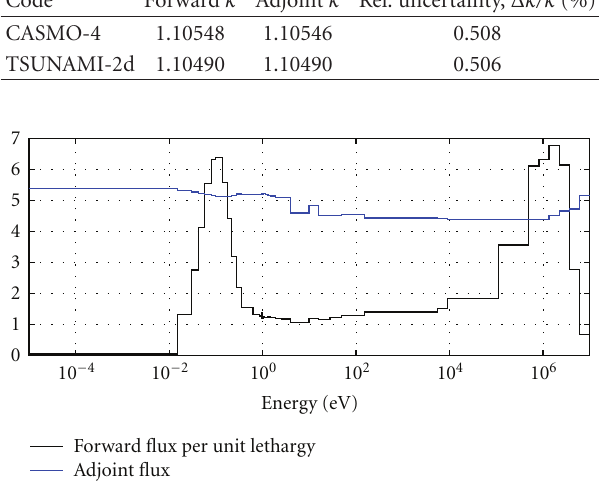
Figure 2: Volume-averaged forward flux and fundamental adjoint